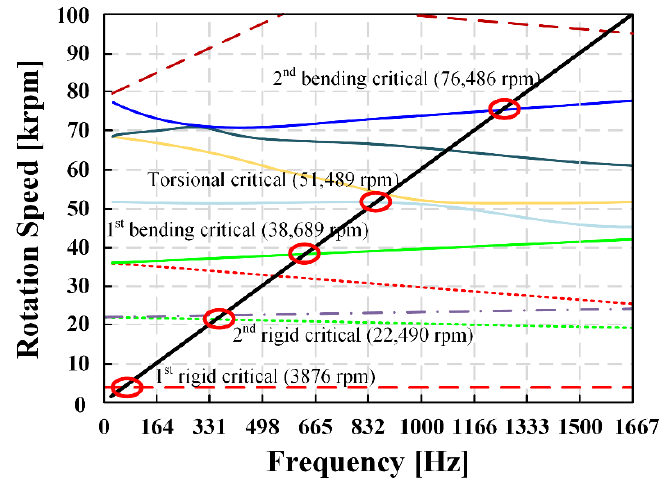
Figure 8. Analysis results of the critical speed characteristic.